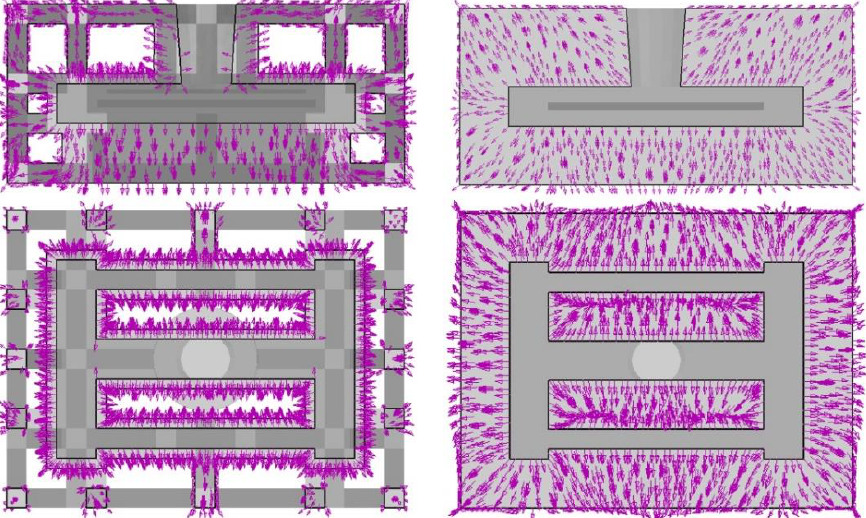
Figure 12. Comparison of the heat flux of ( a ) the skeletal sand mold and ( b ) traditional sand mold at 2500 s; the arrow size is proportional to the intensity of the heat flux.